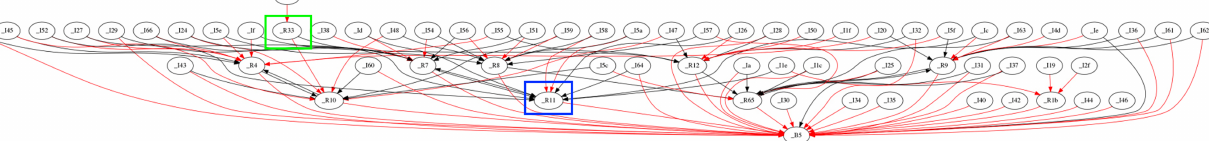
Figure 6. The PEAR impact on network topology evolution: phase 3. The device highlighted with the green square belongs to a low energy profile whereas the device belonging to a high energy profile is highlighted with a blue square.